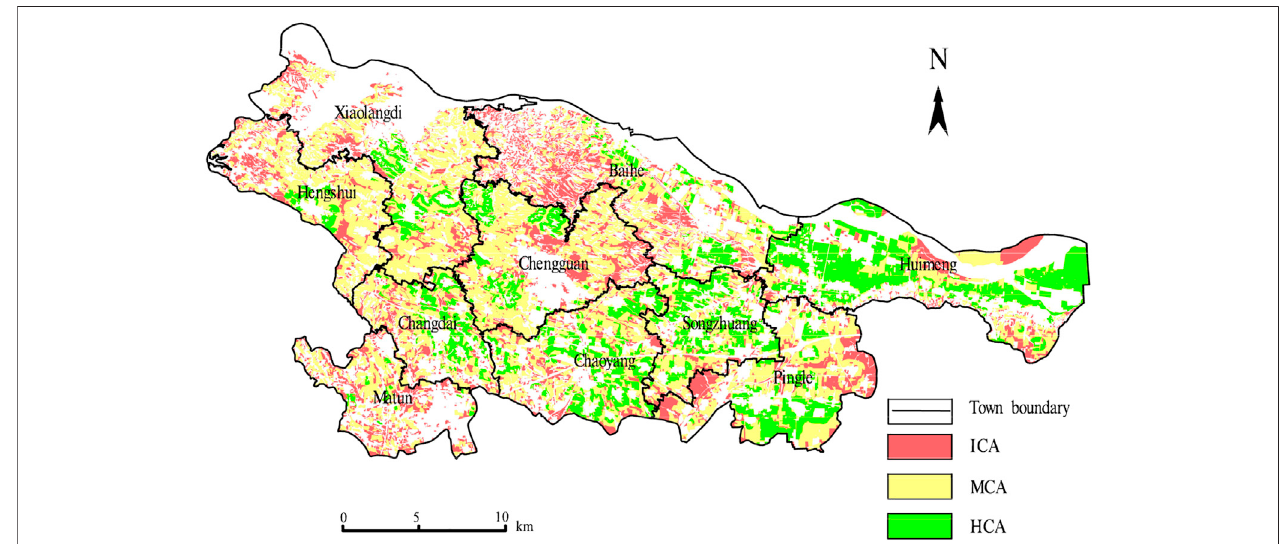
FIGURE 4 | Map of the spatial distribution of farming conditions in Mengjin